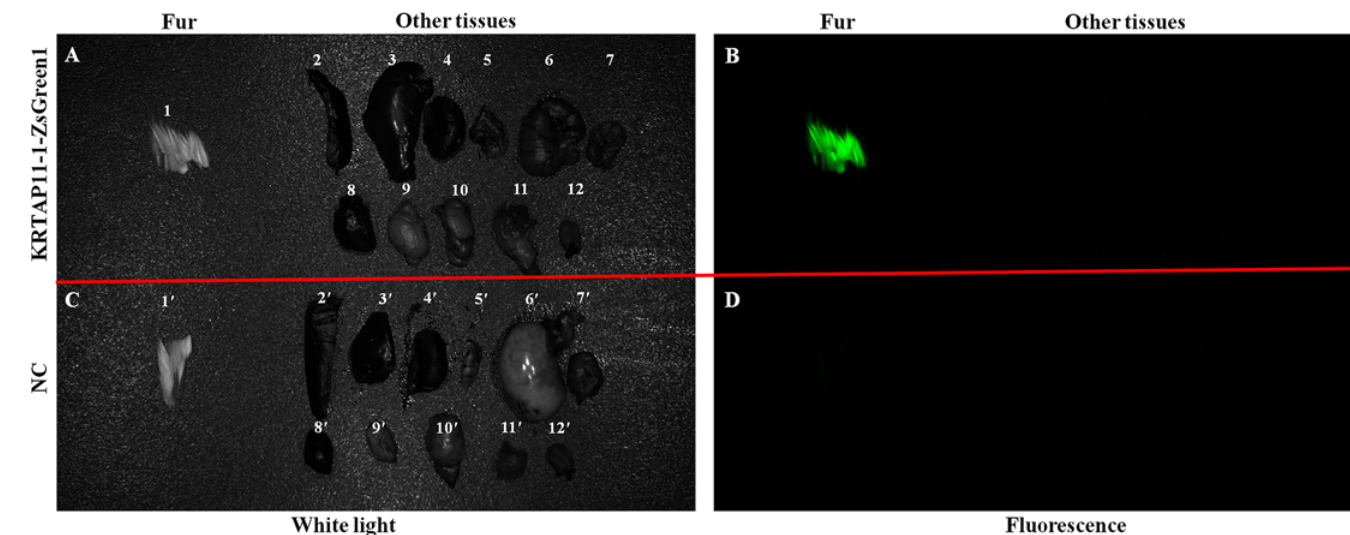
PLOS ONE | DOI:10.1371/journal.pone.0153936 April 21,